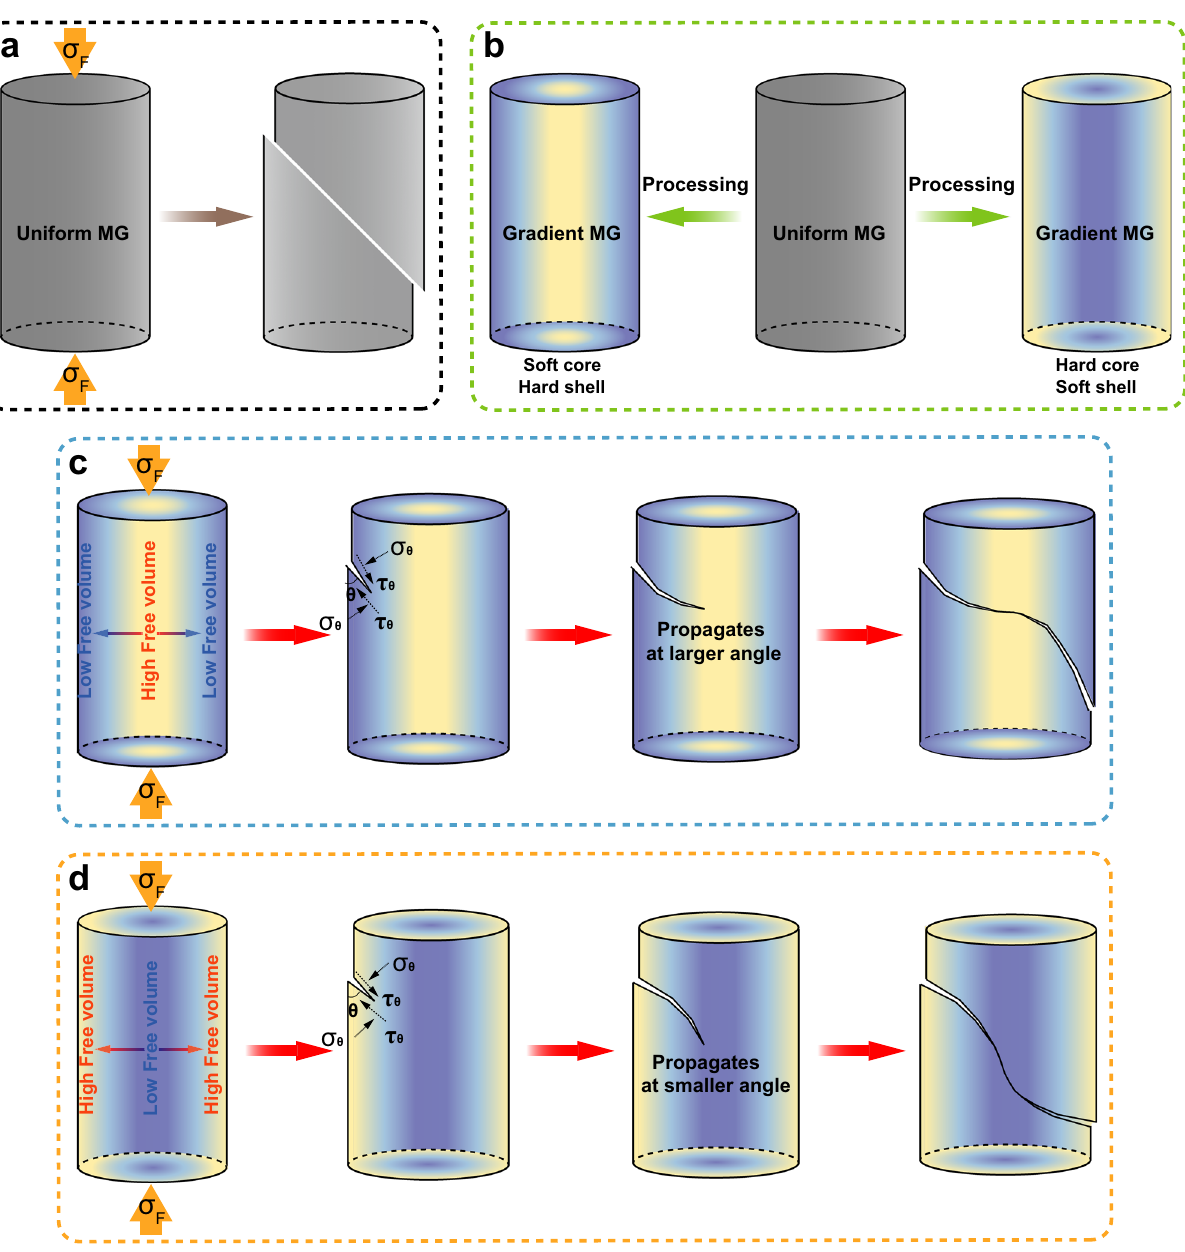
Fig. 1 Schematic description of GMG. a Schematic representation of one dominant shear band in uniform MG. b Schematic diagram of proposed GMG. c Proposed shear band de fl ection mechanism in the GMG with hard shell and soft core during the uniaxial compression process. The hard shell and soft core were coloured in blue and yellow. d Proposed shear band de fl ection mechanism in the GMG with soft shell and hard core during the uniaxial compression process. The soft shell and hard core were coloured in yellow and